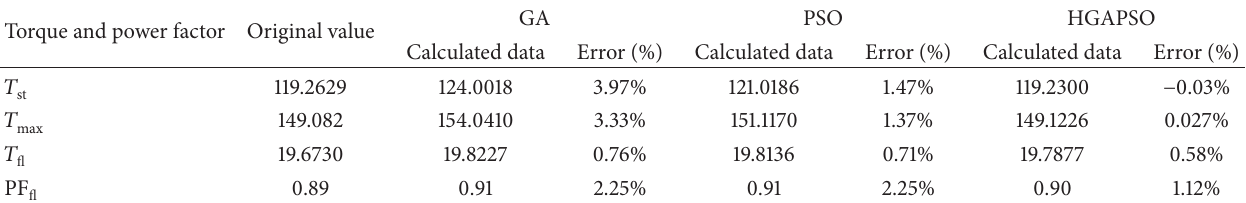
Table 2: Starting torque, maximum torque, full load torque, and full load power factor calculated by GA, PSO, and HGAPSO. Torque and power factor Original value